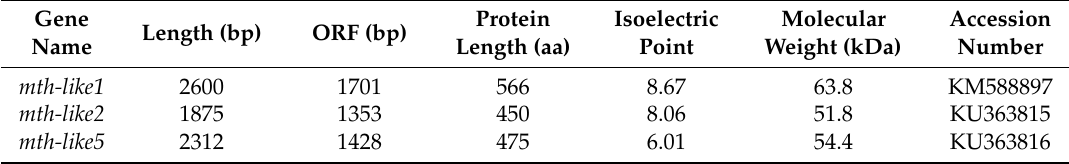
Table 2. Basic sequence information of mth-like genes in Dastarcus helophoroides .